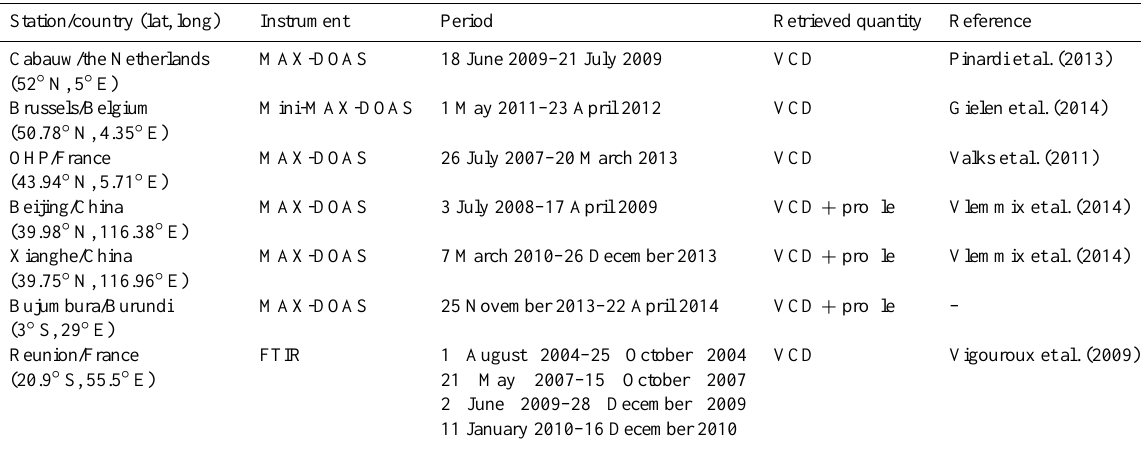
Table 3. Summary of ground-based measurements available at